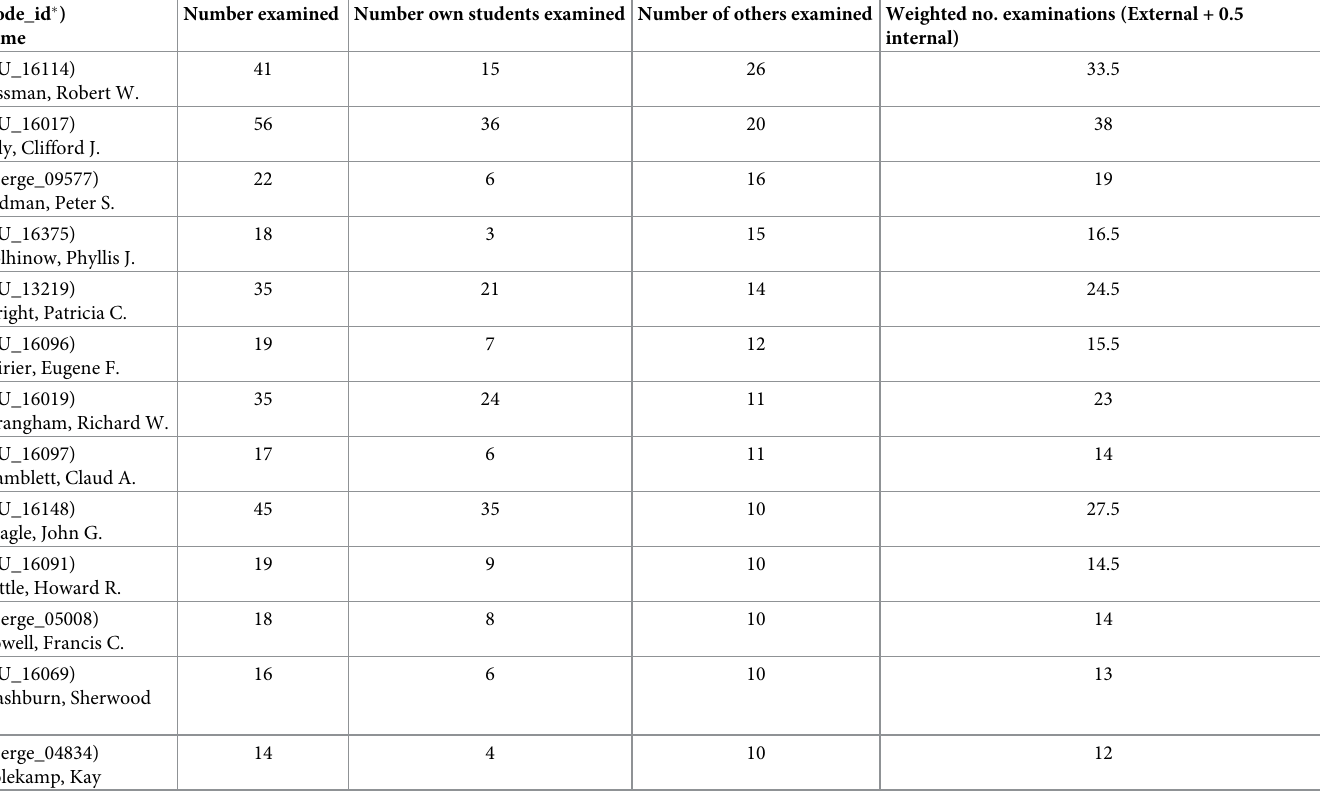
Table 3. Ranking of primatologists by examining